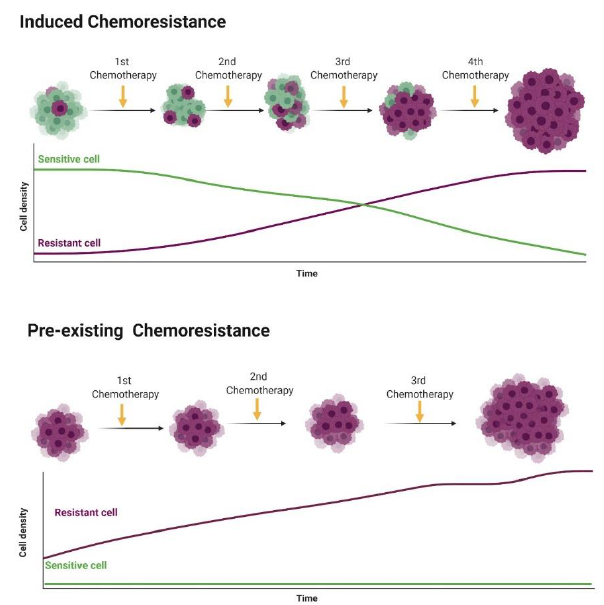
Figure 1. Representation of the tumor microenvironment factors associated with chemoresistance. During chemotherapy, the tumor microenvironment shows cancer-associated macrophages (CAM), cancer stem cells and other immune cells that induce paracrine signaling, leading to tumor resistance induced by drugs. Usually, the modulation of the tumor microenvironment after chemotherapy induces the recruitment of CAM and a reduced cytotoxic response of T cells, leading to a resistance to apoptosis. Figure created in BioRender (https://biorender.com/).